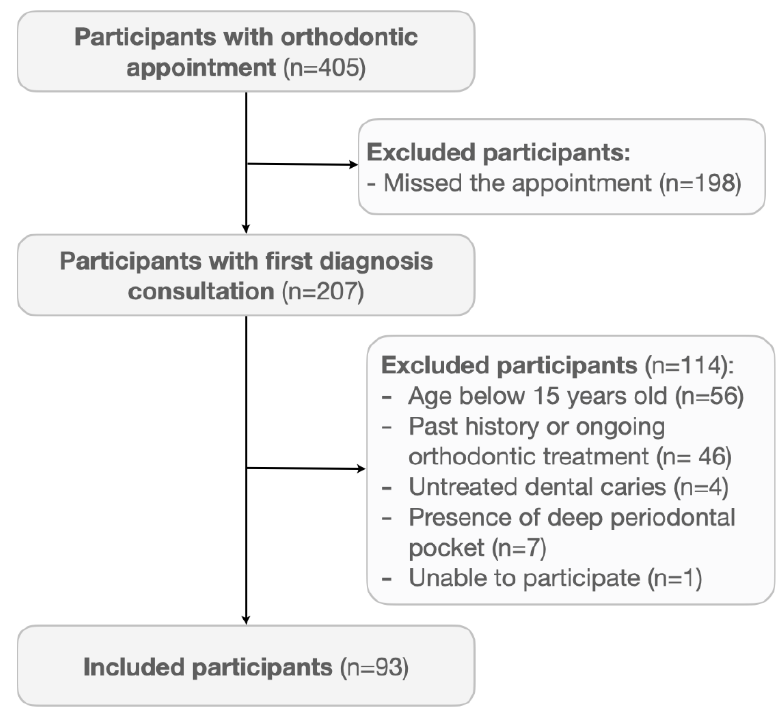
Figure 1. Participants flowchart.